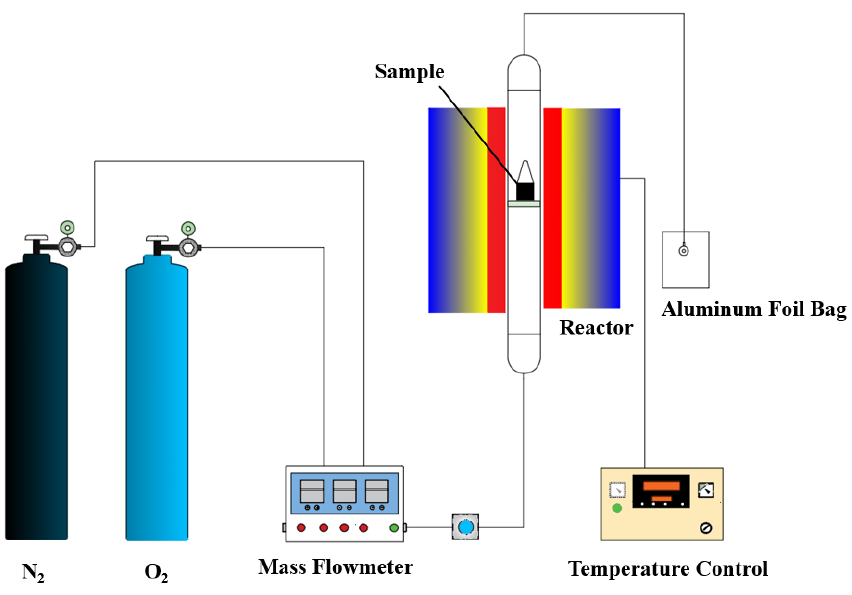
Figure 1. The thermal desorption experimental